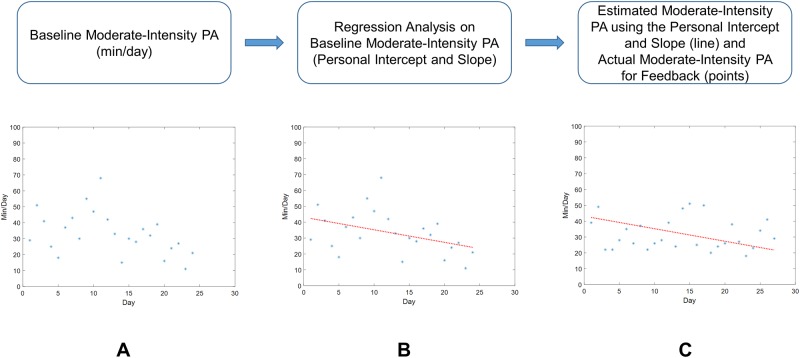
A data pipeline for within-participant analysis.(A) Baseline values of moderate-intensity PA per day over the course of first phase for one participant (ID#1), (B) Baseline data (points) were used to develop a regression model to obtain a fitted/predicted personal intercept and slope (continuous line) for the same participant. The regression line indicates a drop in moderate-intensity PA level over time, (C) Estimated moderate-intensity PA using personal intercept and slope (continuous line) from baseline (Fig 5B) and the moderate-intensity PA for PA Feedback phase (points).